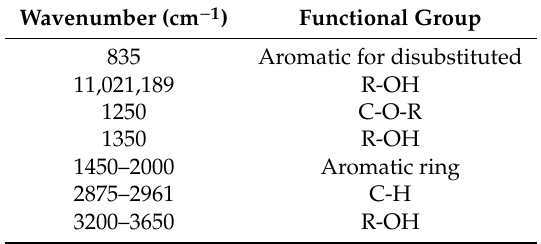
Figure 8. ( a ) NPEG FTIR spectrum at di ff erent reaction times; ( b ) NPEG-UV spectrum at di ff erent reaction times. Table 3. Summary of the structures detected by FTIR in a NPEG reaction